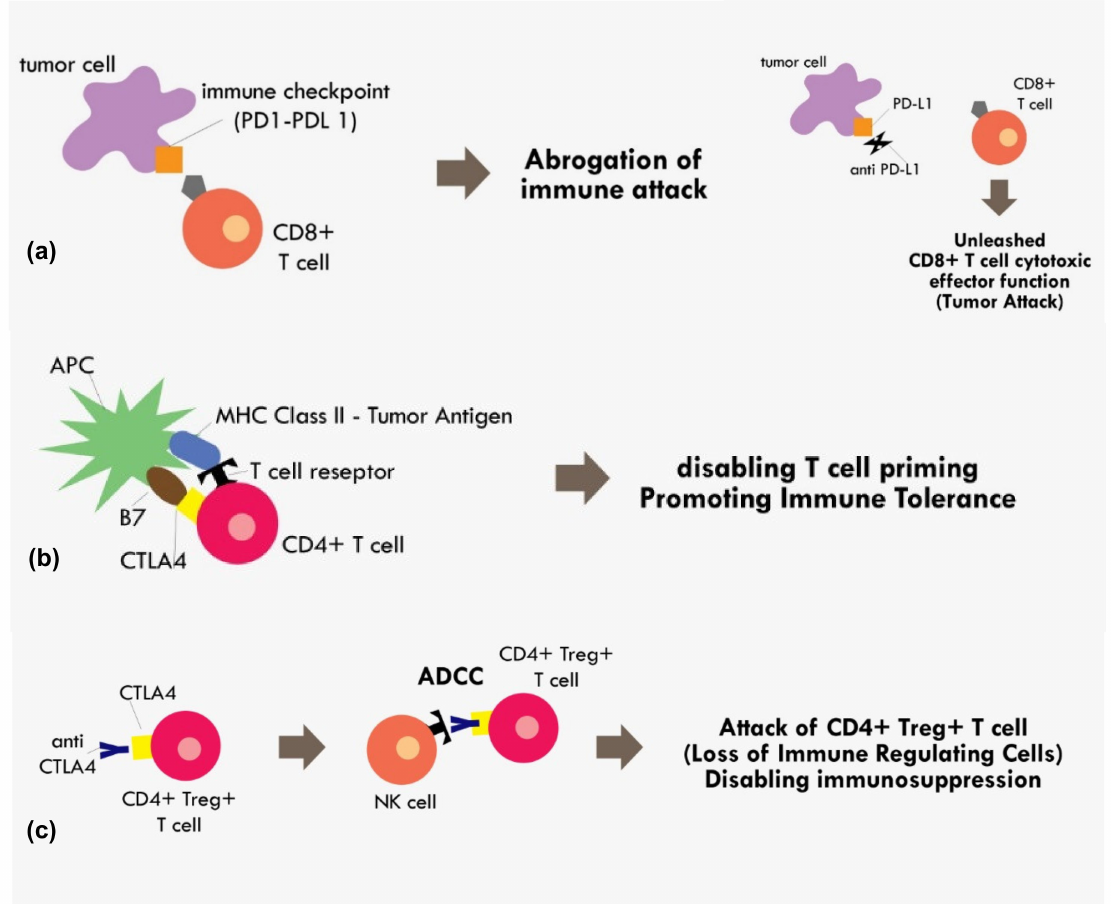
Figure 2. Mechanism of immune checkpoint inhibitions ( a ) PD1–PDL1 binding results in abrogation of those primed CD8 + T cells, while blocking the PD1–PDL1 axis results in unopposed CD8 + e ff ector T cells functions. ( b ) Binding of costimulatory CTLA4 in CD4 + T cells with B7 in APC in the MHC Class II-Tumor antigen presentation process results in cancellation of T cell recognition and priming ( c ) binding of CTLA4 receptor in CD4 + Treg + T cell by monoclonal antibody results in the antibody dependent cellular cytotoxicity (ADCC) process, thus eliminating immunosuppressive T regulatory cells within the tumor